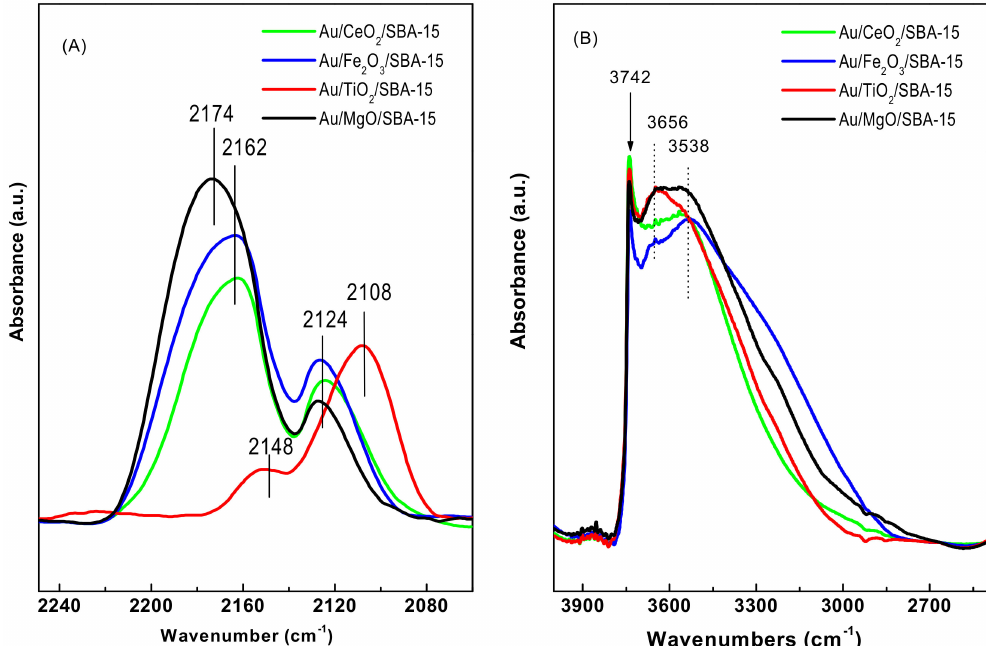
Figure 7. ( A ) DRIFT spectra of CO chemisorbed at RT and ( B ) DRIFT spectra showing the OH region of the pre-treated Au/Mo x /SBA-15